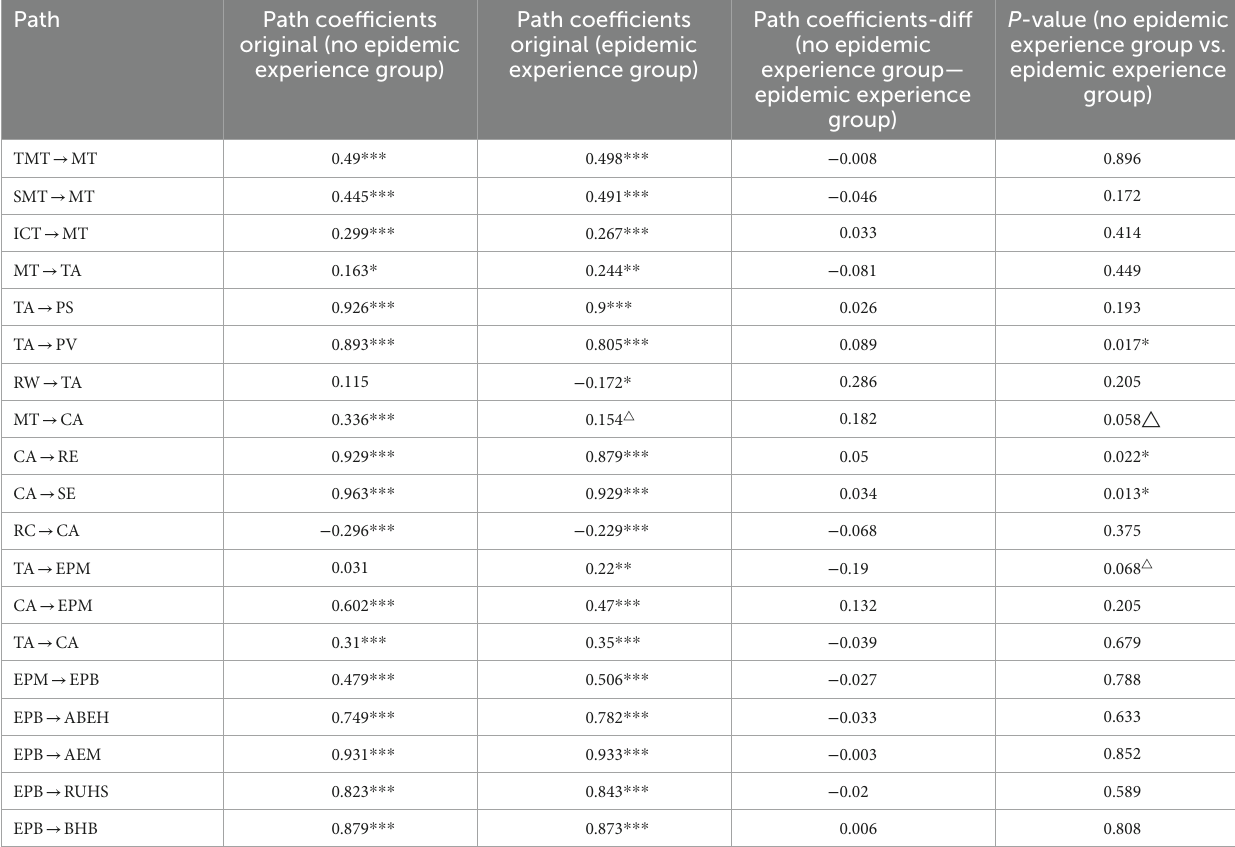
TABLE 2 Multi-group analysis result.